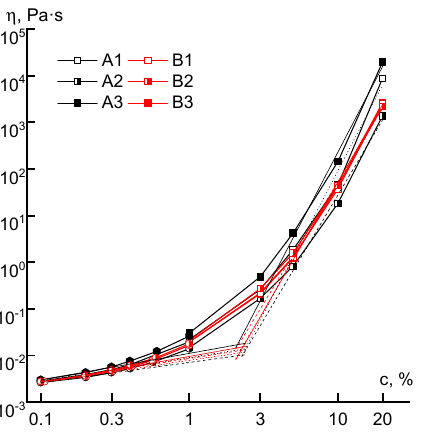
Figure 7. The dependence of the viscosity of series A and B copolymer solutions, measured at a shear rate of ~0.1 s − 1 , on the